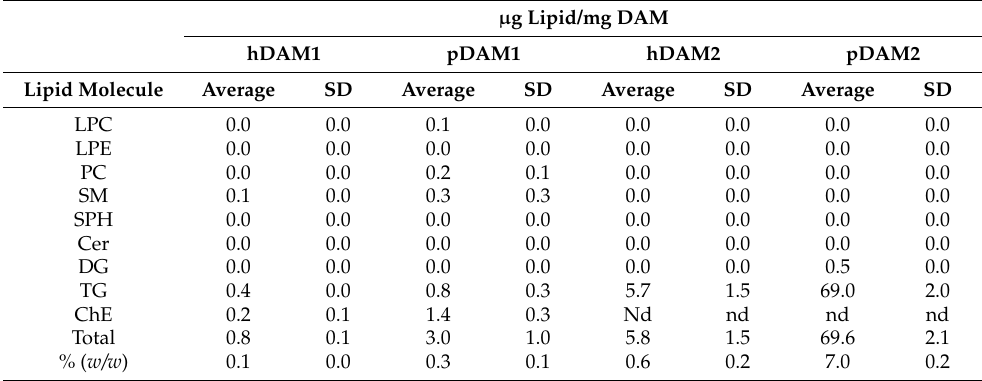
Table 2. Remnant lipid quantity ( µ g/mg DAM) after tissue decellularization in all assayed DAMs by lipid class and percentage ( w/w ) in respect to the DAM dry weight. Values are reported as the mean ± standard deviation of n = 3 samples. Abbreviations: LPC: lysophosphatidylcholine, LPE: lysophosphosphatidyl ethanolamine, PC: phosphatidylcholine, SM: sphingomyelin, SPH: sphin- golipid, Cer: ceramide, DG: diacylglycerol, TG: Triacylglycerol, ChE: cholesterol ester. µ g Lipid/mg DAM